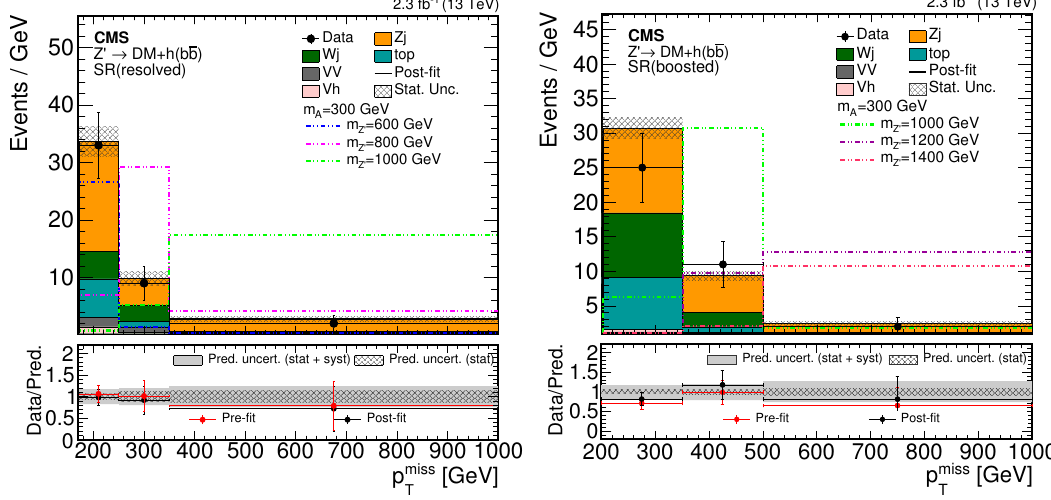
Figure 6 . Post-(cid:12)t distribution of p miss expected from SM backgrounds and observed in data for the T resolved (left) and the boosted (right) regimes in the signal region with three di(cid:11)erent m Z 0 signal points overlaid. Other parameters for this model are (cid:12)xed to m (cid:31) = 100 GeV and tan (cid:12) = g (cid:31) = 1. The cross sections for the signal models are computed assuming g Z 0 = 0.8. The bottom panels show the data-to-simulation ratios for pre-(cid:12)t (red markers) and post-(cid:12)t (black markers) background predictions with a hatched band corresponding to the uncertainty due to the (cid:12)nite size of simulated samples and a gray band that represents the systematic uncertainty in the post-(cid:12)t background prediction (see section 6). The last bin includes all events with p miss > 350 (500) GeV for the T resolved (boosted) regime.